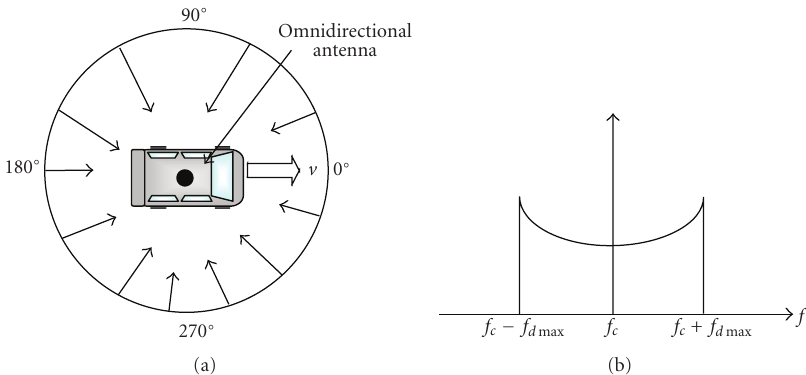
Figure 2: Doppler frequency shift for omnidirectional antenna. (a): In coming RF waves, (b): Doppler frequency distribution.